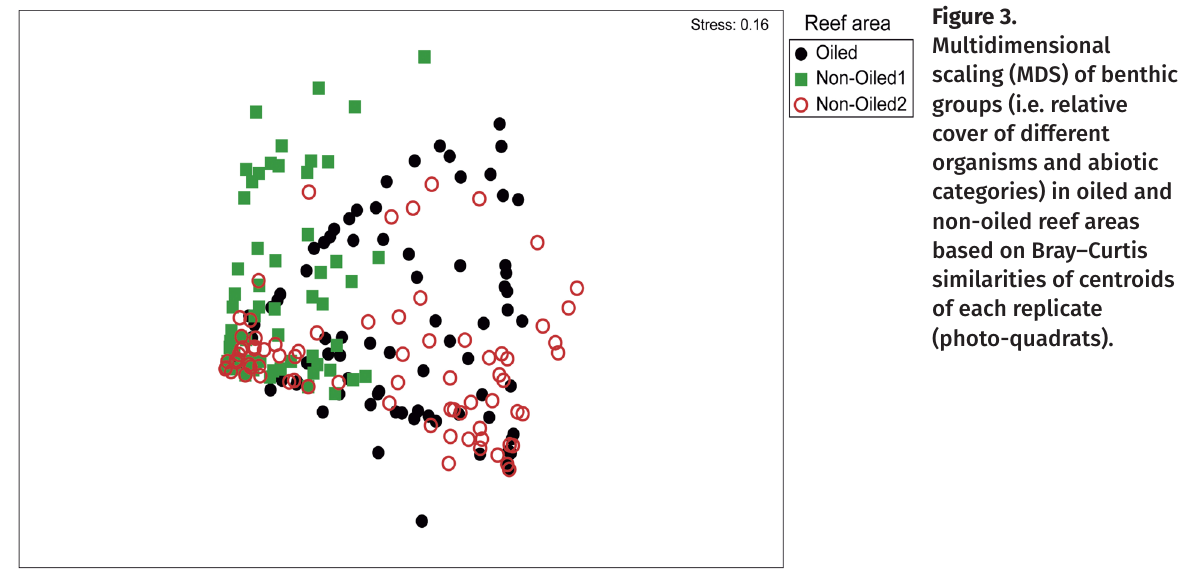
Figure 3. Multidimensional scaling (MDS) of benthic groups (i.e. relative cover of different organisms and abiotic categories) in oiled and non-oiled reef areas based on Bray–Curtis similarities of centroids of each replicate